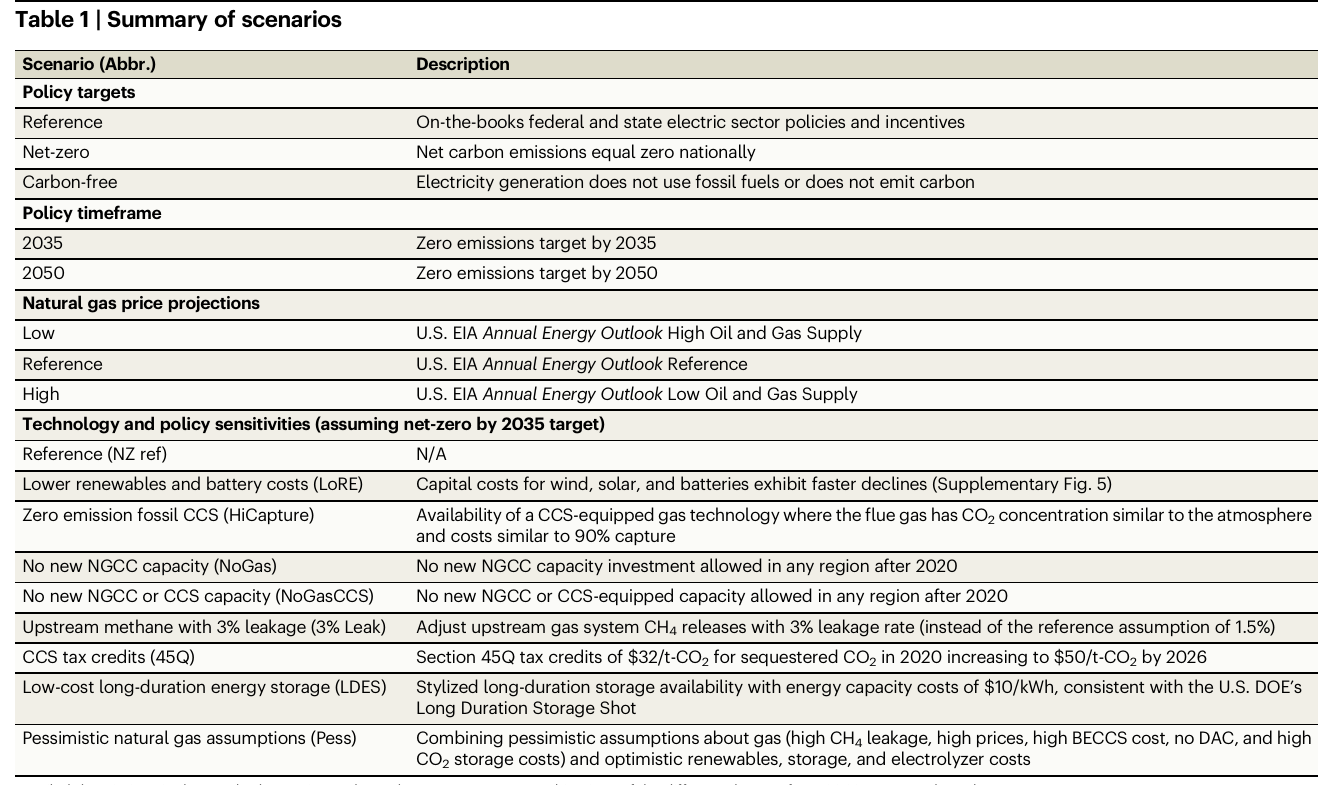
Table 1 | Summary of scenarios Scenario